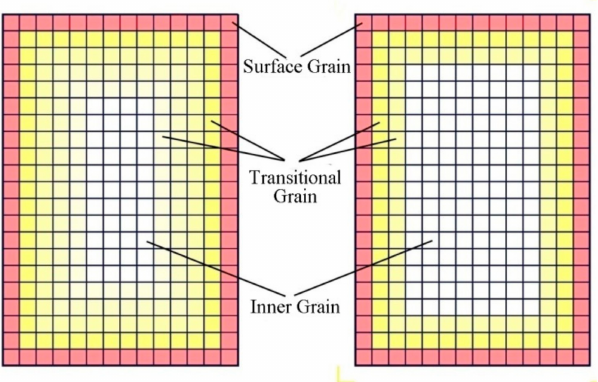
Figure 8. Schematic picture of the transition layer model: The left is the actual distribution model of three kinds of grains, and the right is the model after simplifying the transition layer into two layers of